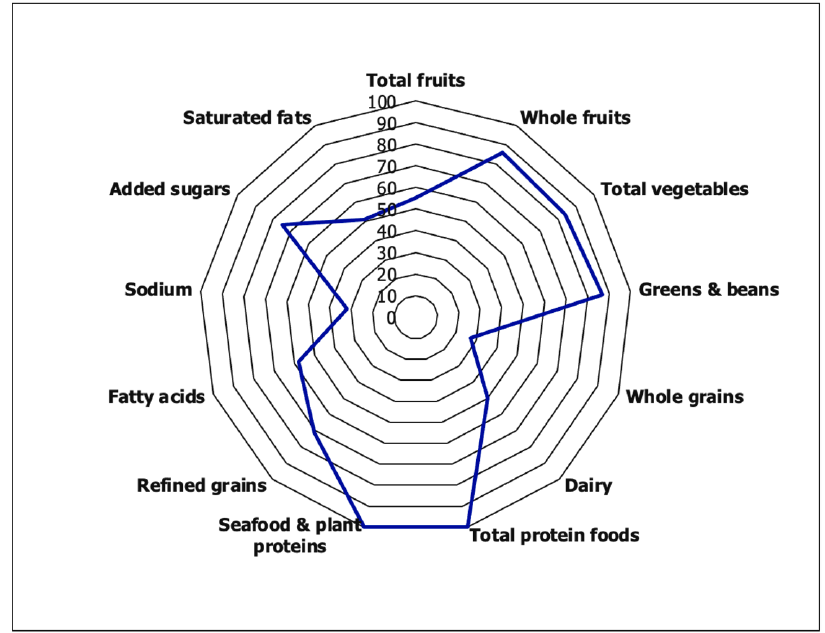
Figure 1. Healthy Eating Index mean component scores.